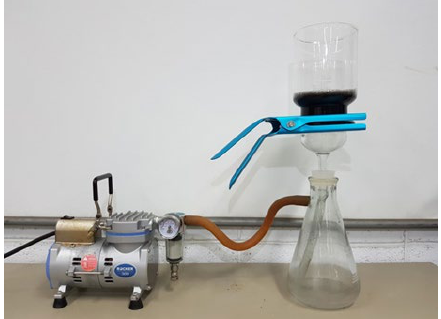
Figure 2. Experimental setup of vacuum filtration.